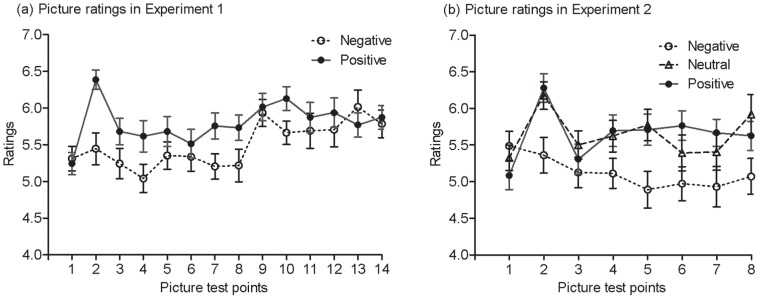
Rating of pictures at fourteen time points in Experiments 1 and 2.The first time was before mood induction and the second one was after the mood induction. Each of the last 12 tests was before each of the 12 training blocks. Error bars depict standard errors.